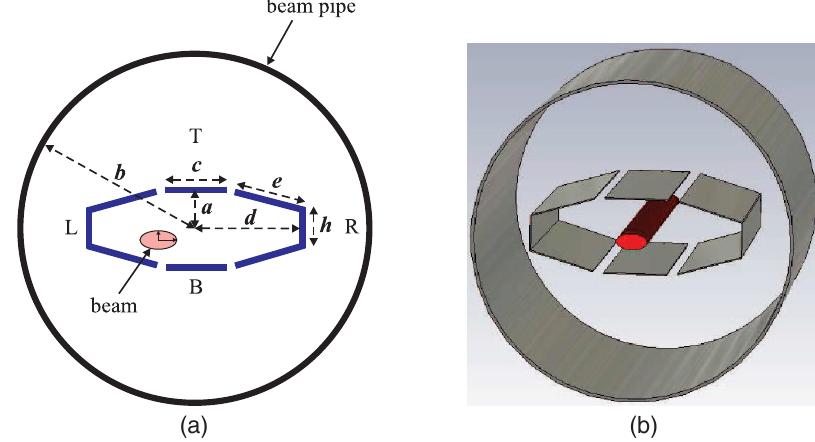
FIG. 11. (a) Front view of the pickup design installed at GSI SIS-18; a ¼ 35 . 3 mm, b ¼ 150 mm, c ¼ 60 mm, d ¼ 100 . 3 mm, e ¼ 62 . 5 mm, h ¼ 32 mm, electrode length l ¼ 210 mm, length of the beam pipe l design with the modeled beam in red, from CST EMS.